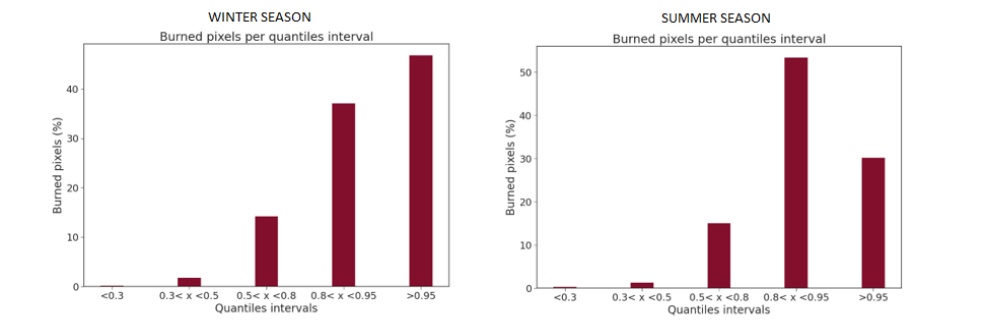
Figure 17. On the left, the susceptibility distribution grouped in percentile classes for the winter seasonal map. On the right, the susceptibility distribution grouped in percentile classes for the summer seasonal